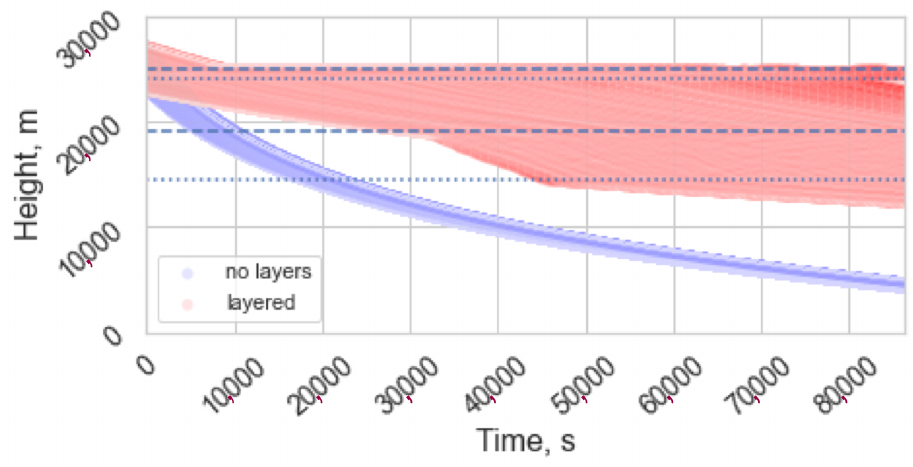
Figure 7. Longitudinal time-section to one day (86,400 s) through Lagrangian dispersion model outputs showing paths of 30 µ m particles. Blue particles, weak homogeneous turbulence with high- turbulence layers removed, and turbulence diffusivity set to low value through depth of atmosphere; red particles, turbulence layering as in Table 4 and Figure 6 for Pinatubo. Note 18 h = 64,800 s. Existence of more turbulent layers enhances persistence of